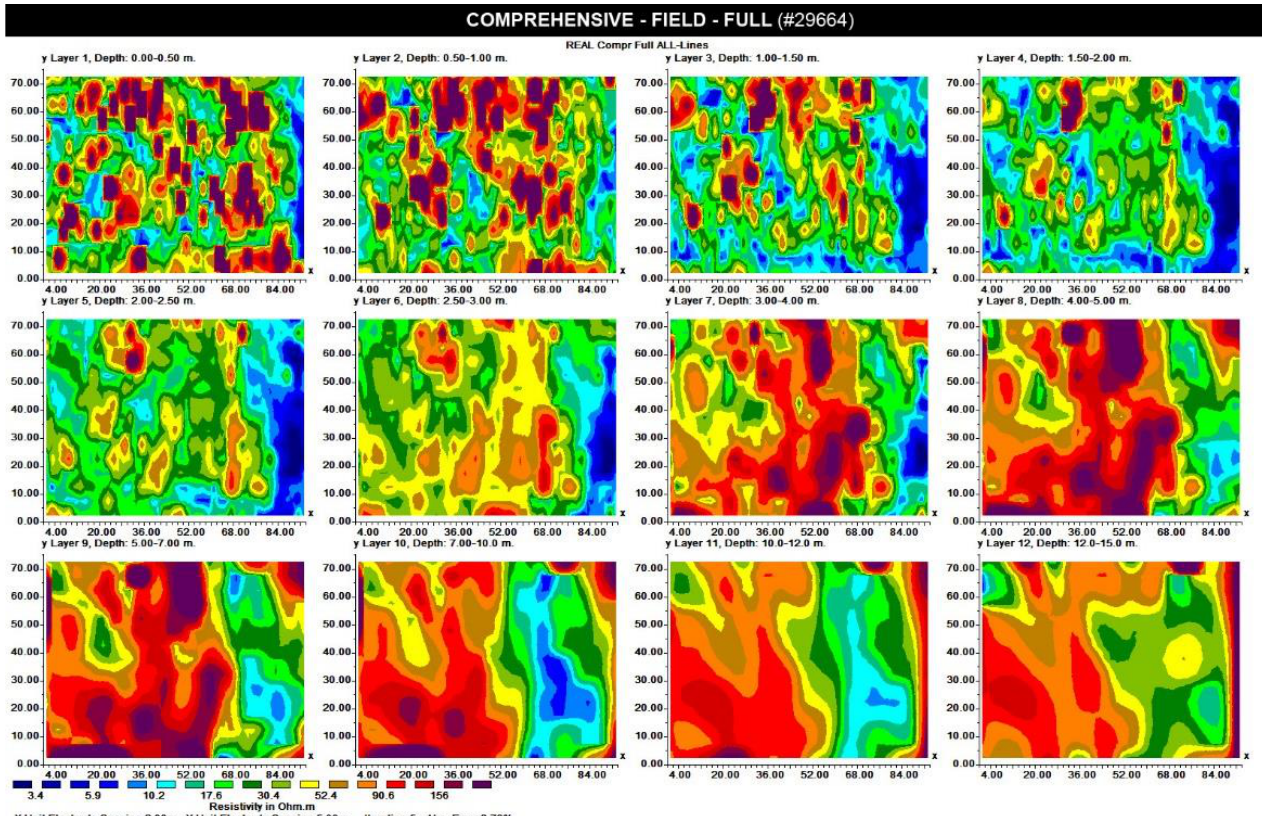
Figure 14. Inversion results from the comprehensive field data set. Figure 13. Inversion results from the comprehensive field data set. Figure 13. Inversion results from the comprehensive field data set.